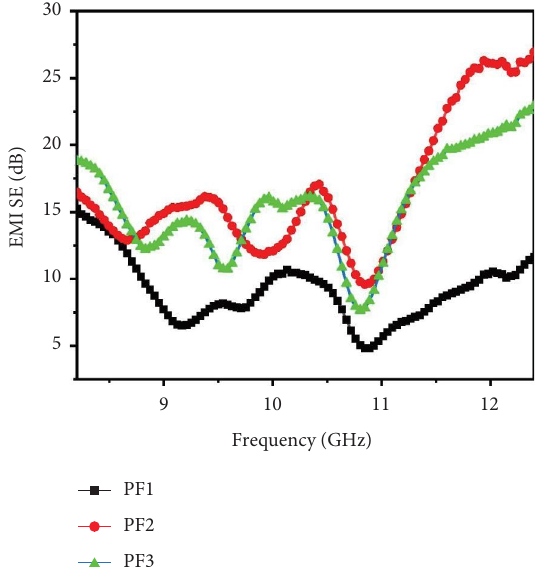
Figure 17: EMI SE (dB) of PF1, PF2, and PF3.